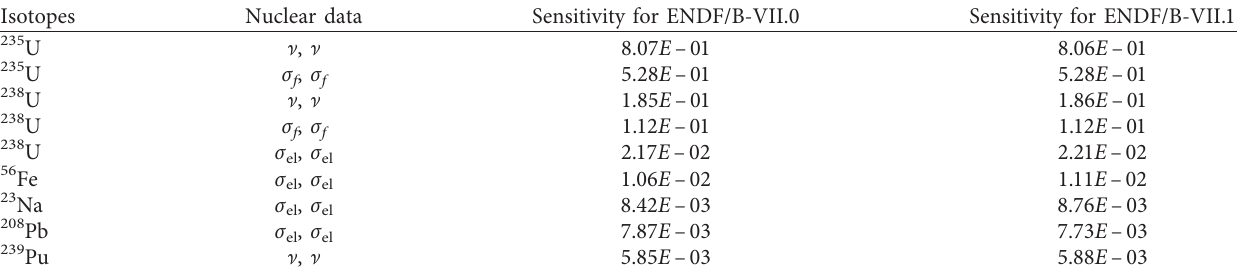
(positive direction). eff